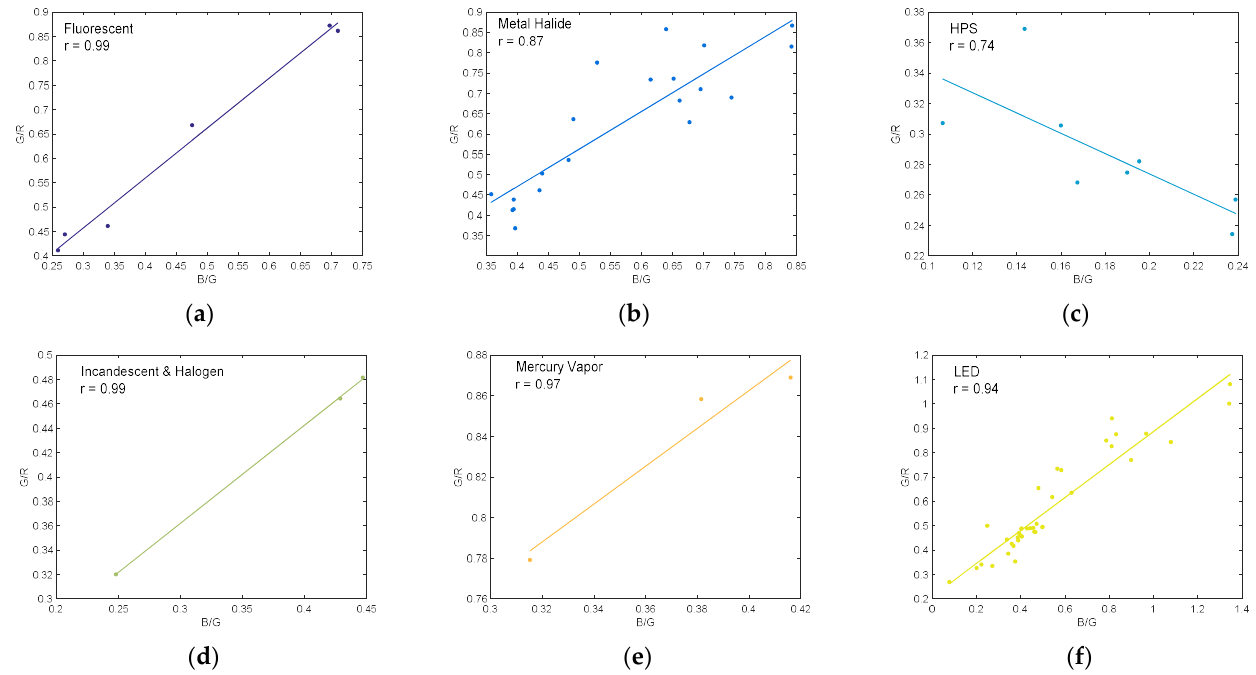
Figure 5. B/G vs. G/R ratios of the simulated synthetic bands: Fluorescent ( a ), Metal Halide ( b ), HPS ( c ), Incandescent ( d ), Mercury Vapor ( e ), and LED ( f ) lamps. Note : LPS lamp, reporting G/R = 0.18 and B/G = 0.02, is the only representative of the type and is not depicted in the figure.